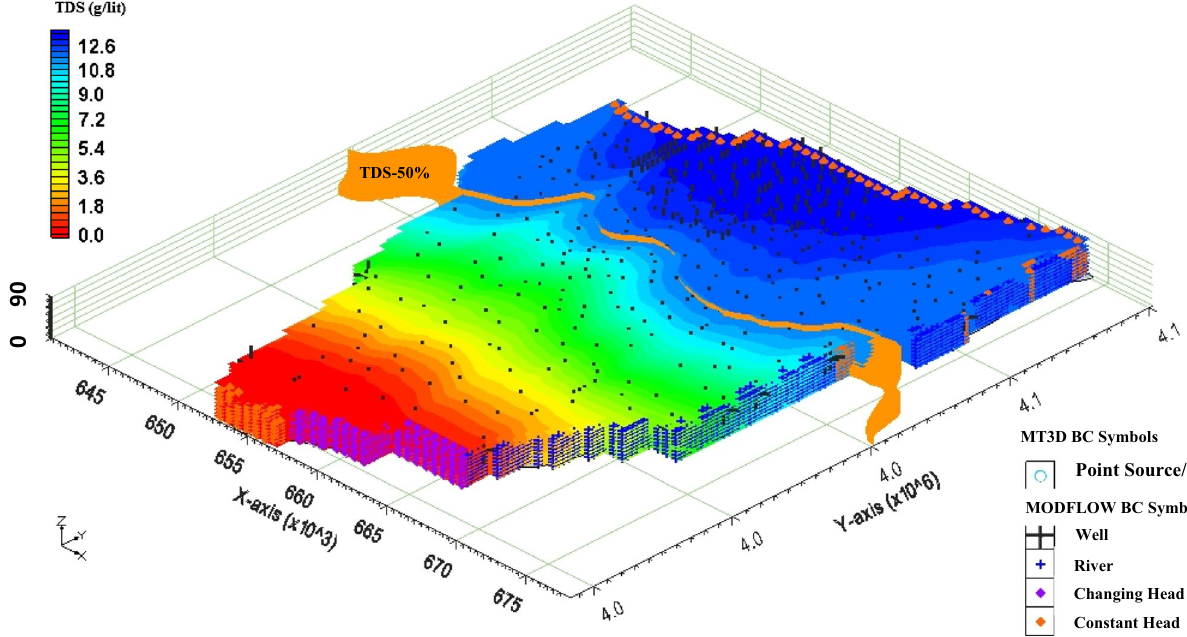
Fig. 4 TDS contour after 1-year stress period in the steady state